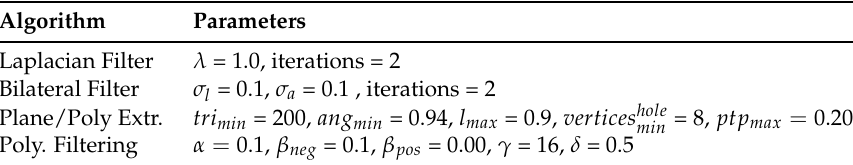
Table 3. Polylidar3D Parameters for Rooftop